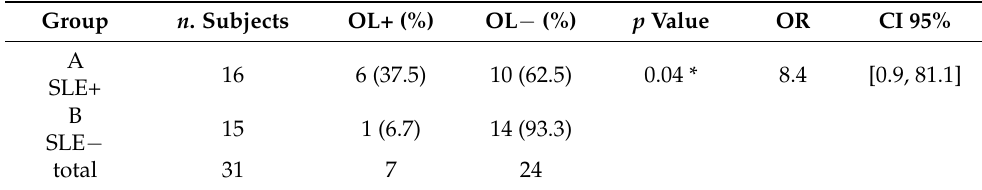
Table 3. Oral lesions (OL) in patients with systemic lupus erythematosus (SLE+) and control sub- jects (SLE − ).